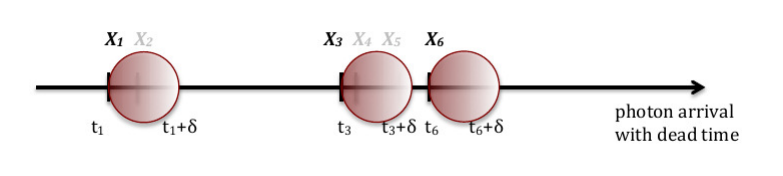
and t 5 are censored during the dead periods induced by those arriving at t 1 and t 3 .